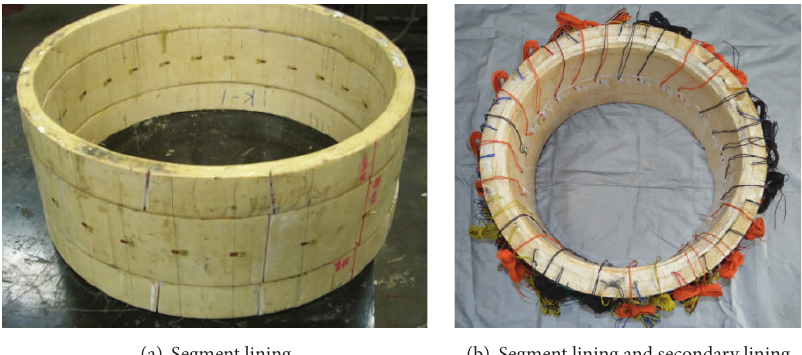
Figure 9: Test model of double